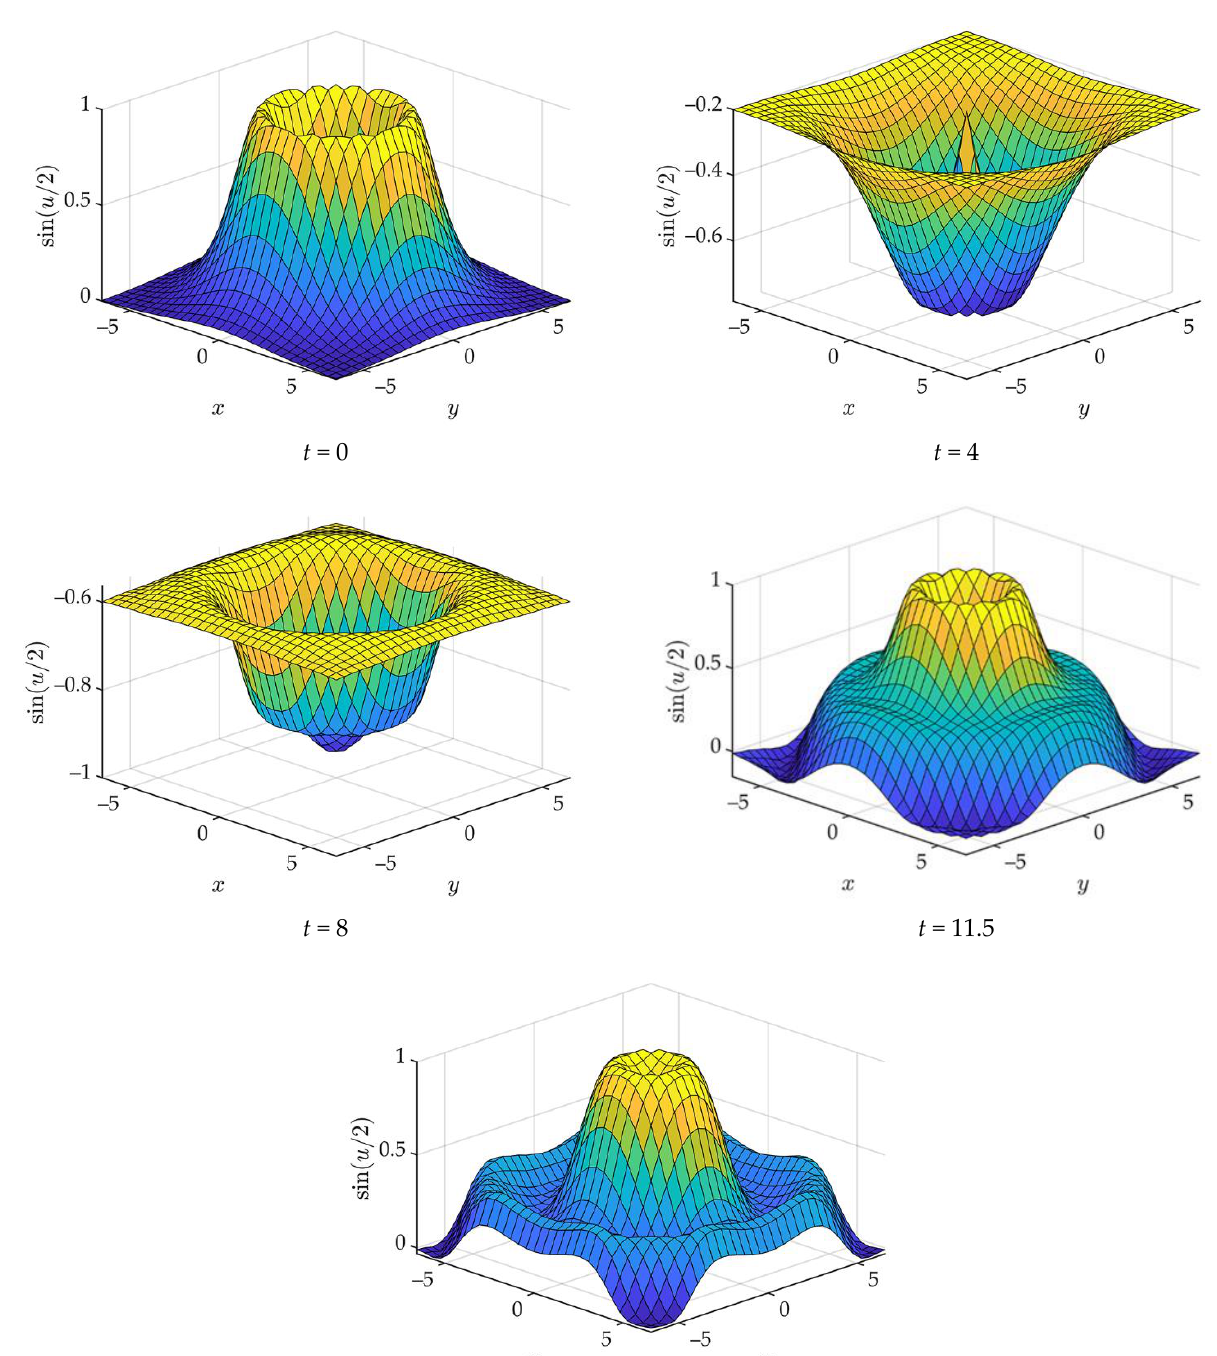
Figure 4. Evolution of the circular ring soliton arising in Case II of Example 3.